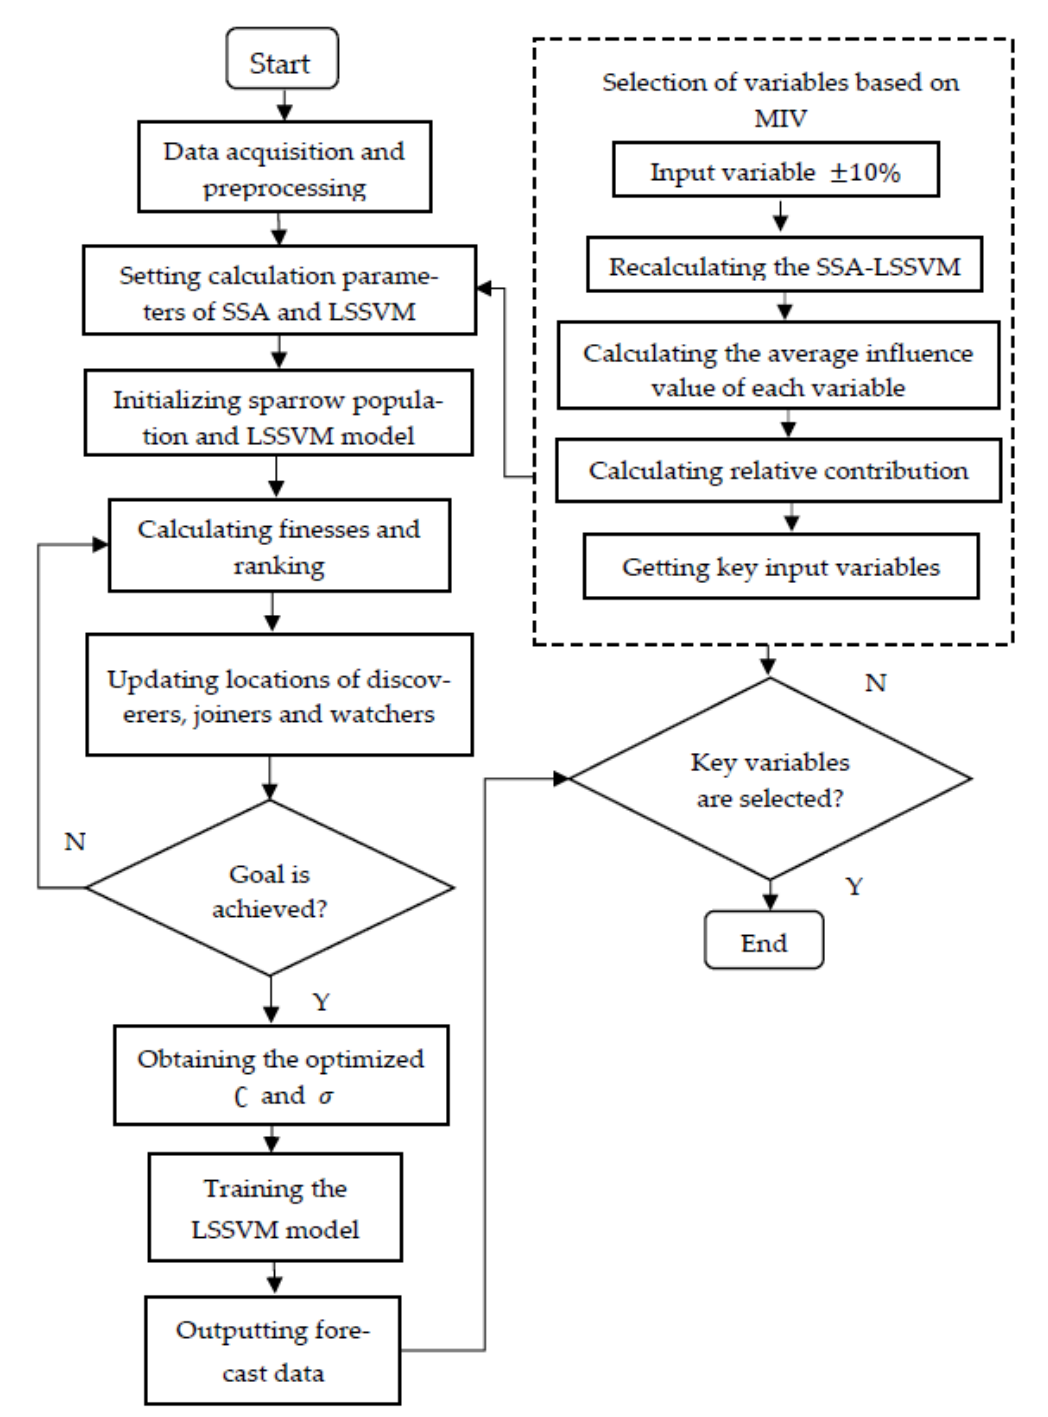
Figure 1. Flow chart of the prediction model proposed in this paper.